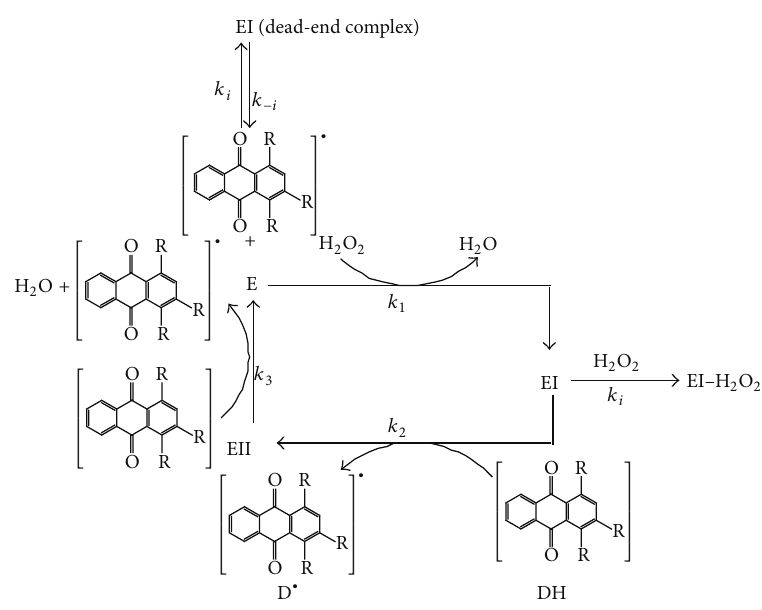
O -mediated oxidation of AV 109 and AB 225 by HRP modeled by ping-pong bi-bi 2 2 Dye Without dye inhibition inhibition